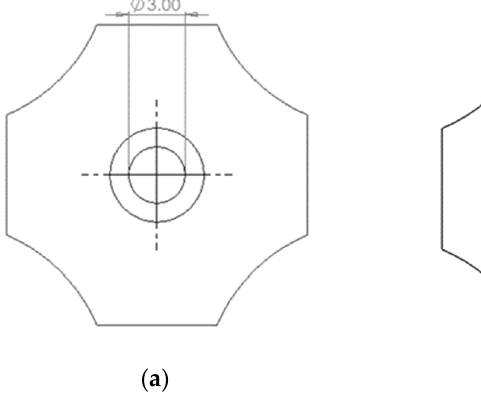
( b ) Figure 8. LCD—effects of channel diameter on: ( a ) Maximum cell temperature; ( b ) Cell temperature difference. The relationship presented in Figure 8a is due to a combination of factors. On the one hand, since the inlet mass flow rate remains the same in each case but the fluid channel diameter is decreased (note the inlet in question is the inlet to the upper reservoir, for which the parameters are not changed), the water pressure and hence the fluid velocity is increased, which increases the heat transfer coefficient (see Equations (9) and (10)), providing increased levels of cooling to the lithium-ion cells. On the other hand, this effect is cancelled out by the fact that the heat transfer area between the fluid and the inside of the aluminium channel is decreased when the diameter is decreased. This results in a